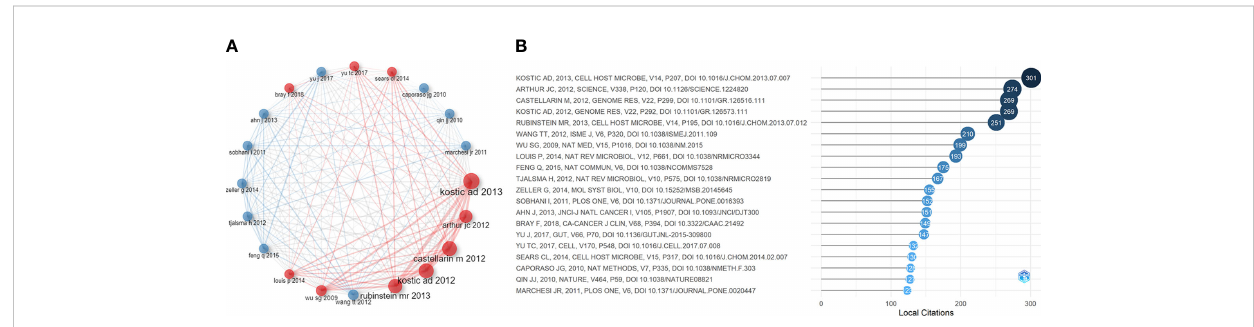
FIGURE 6 (A) Co-citation network of the top 20 most cited references in IM/CRC research. (B) The top 20 most cited references in IM/CRC research.